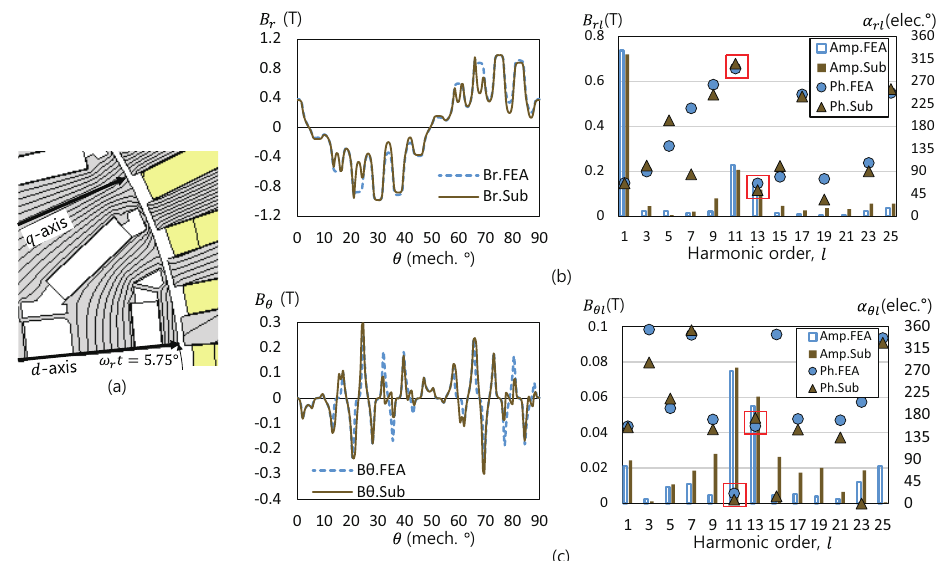
Figure 5. Comparisons of instantaneous air-gap fields when the reluctance torque ripple is maximum: ( a ) flux lines, ( b ) radial fields, and ( c ) circumferential